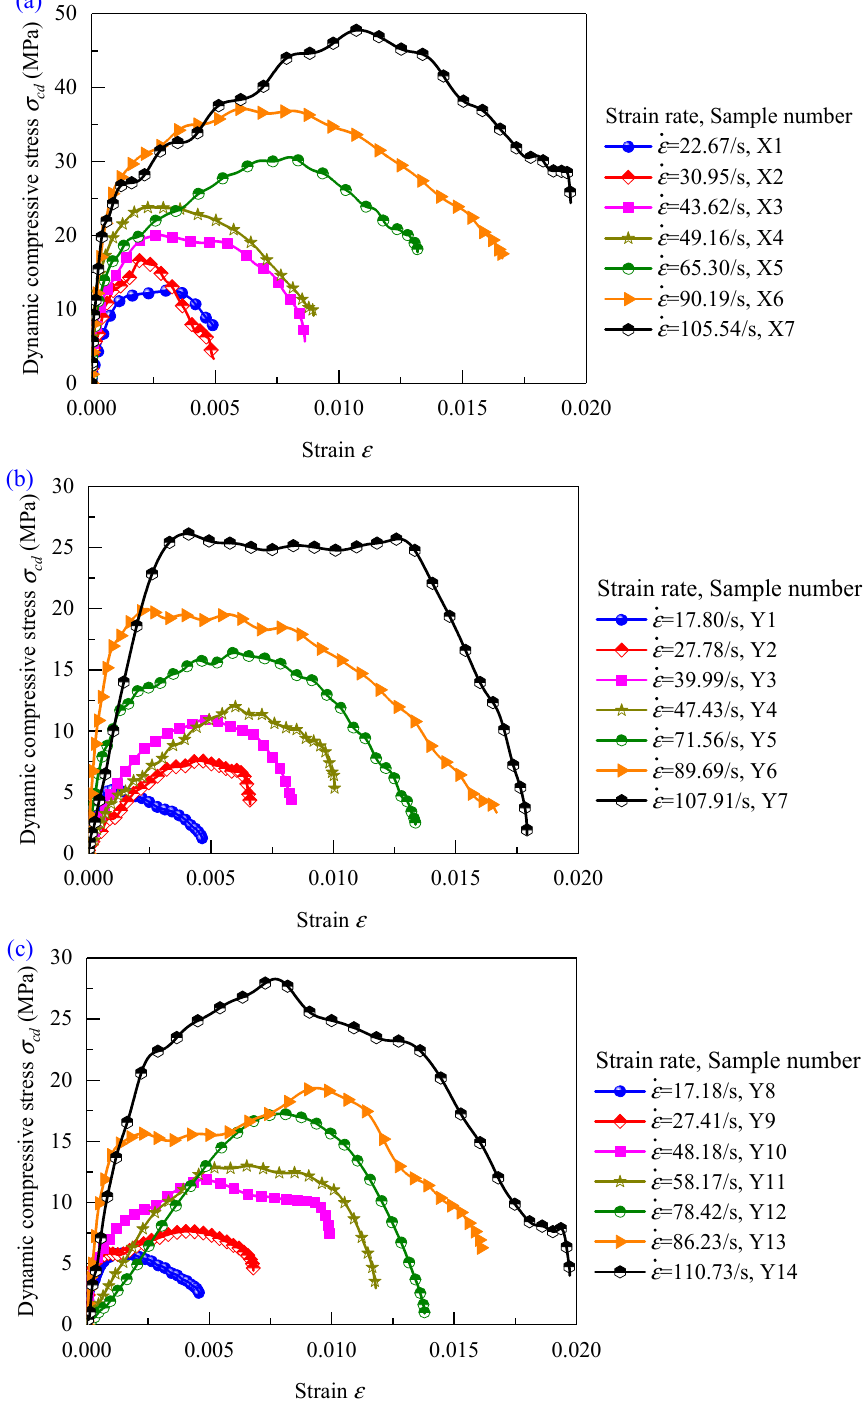
Figure 4. Dynamic stress-strain curves of ( a ) Xinzhouyao (outburst-resistant) coal specimens, ( b ) and ( c ) Xintian (outburst-prone) coal specimens in compressive SHPB test.